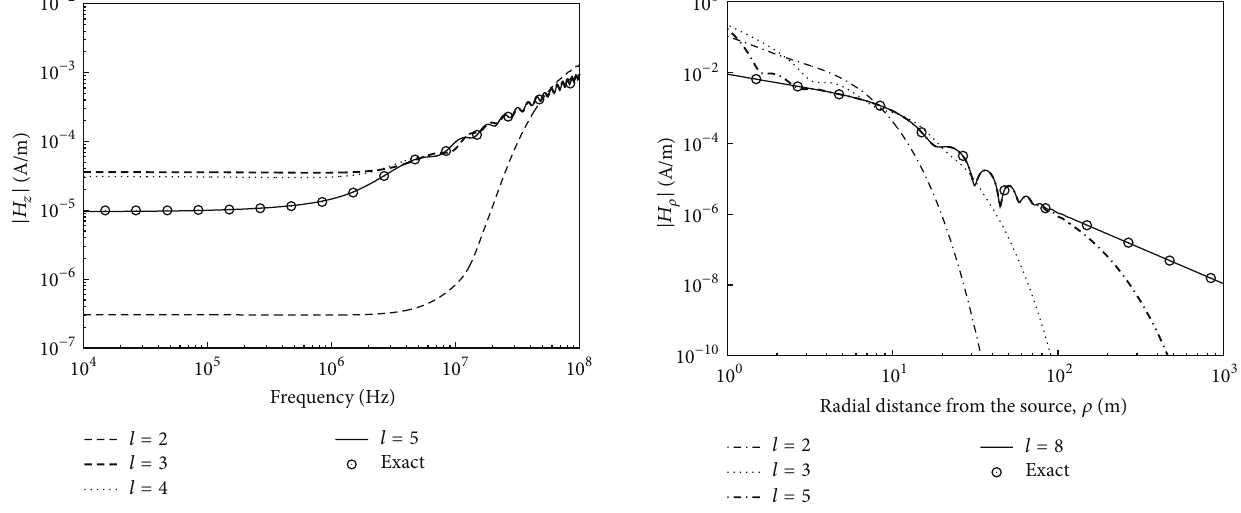
Figure 5: Amplitude-frequency spectrum of 𝐻 𝑧 , computed at 𝜌 = 20 m from the source point.